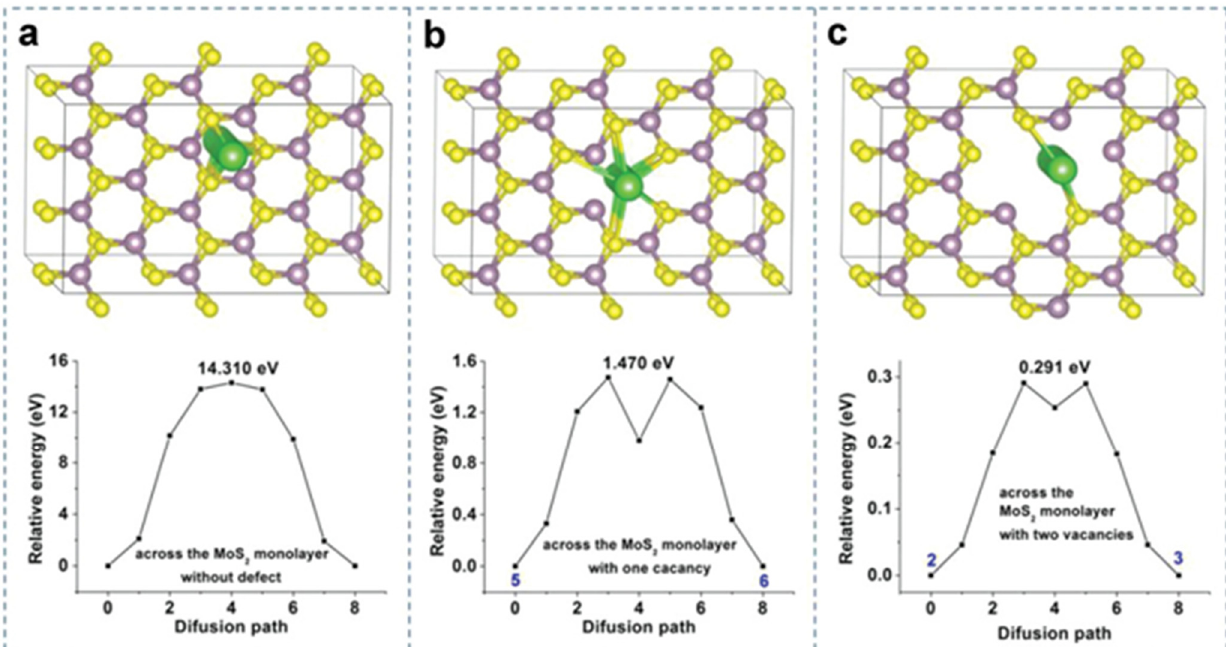
Figure 6. The pathways of the lowest Na + diffusion barrier across ( a ) the indefective MoS 2 monolayer, ( b ) defective MoS 2 with one vacancy, and ( c ) two vacancies and their corresponding potential energy curves. The purple, yellow, and green balls represent Mo, S, and Na, respectively. Reproduced with permission of ref. [145]. Copyright 2019. WILEY-VCH Verlag GmbH & Co. KGaA,